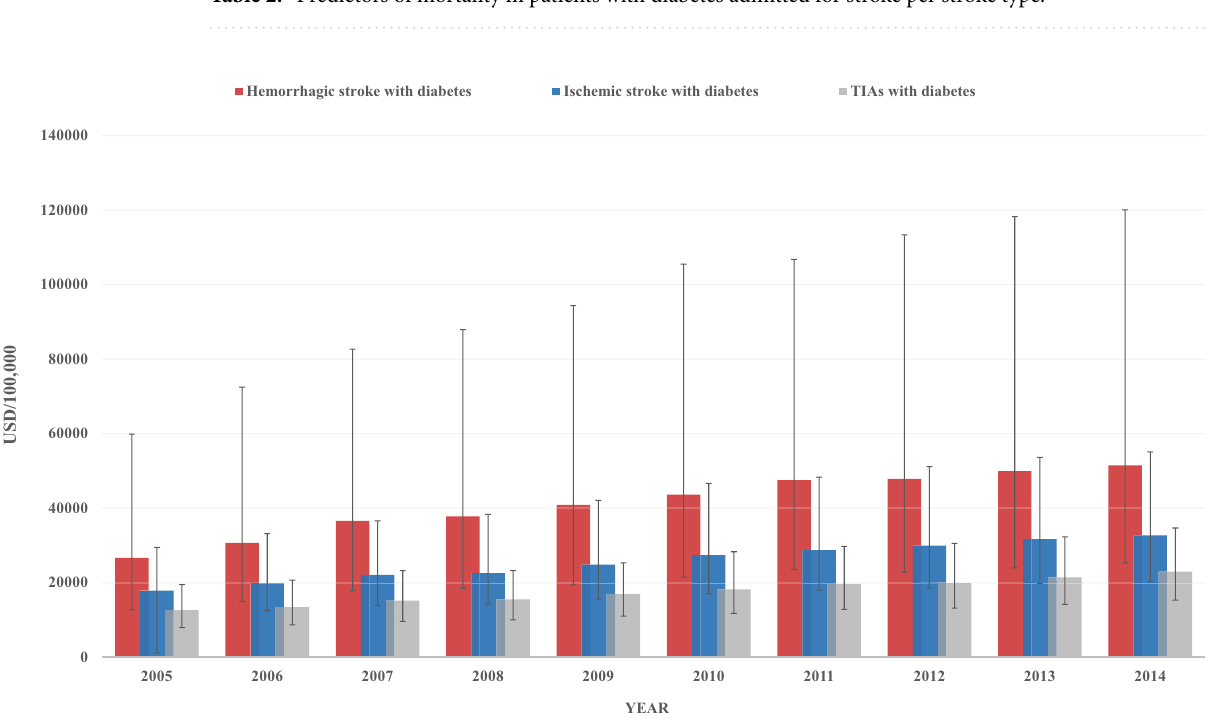
Table 2. Predictors of mortality in patients with diabetes admitted for stroke per stroke type.